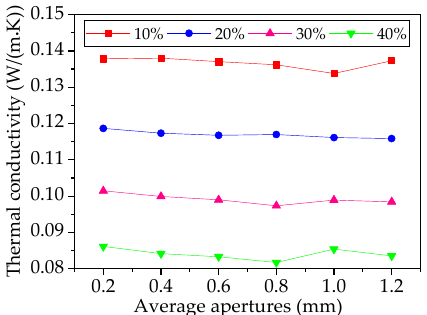
Figure 7. Relationship between average apertures and thermal conductivity at different porosity.